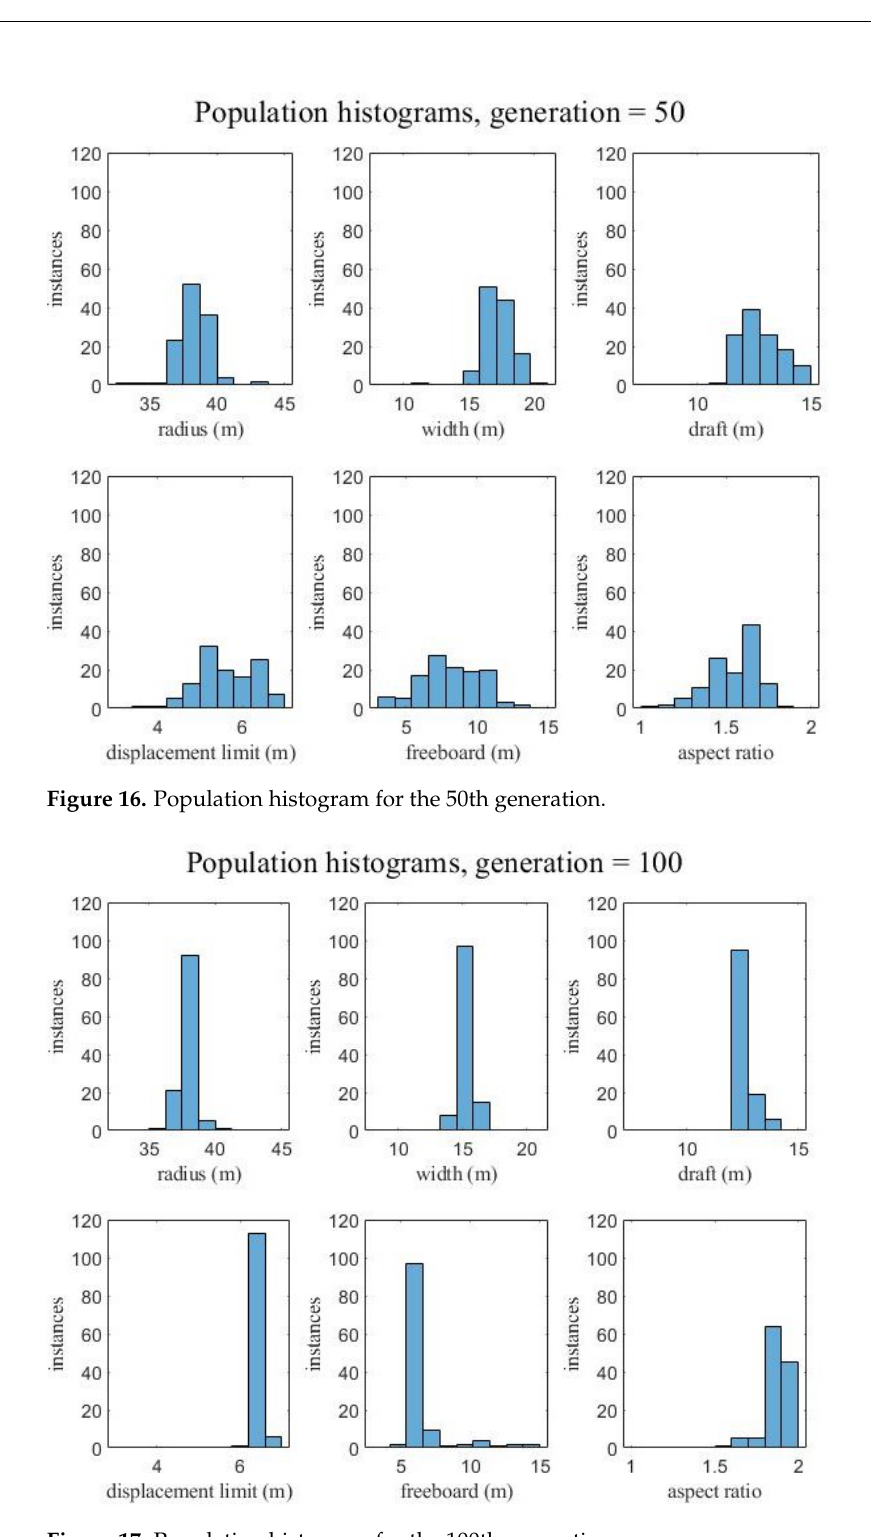
Figure 17. Population histogram for the 100th